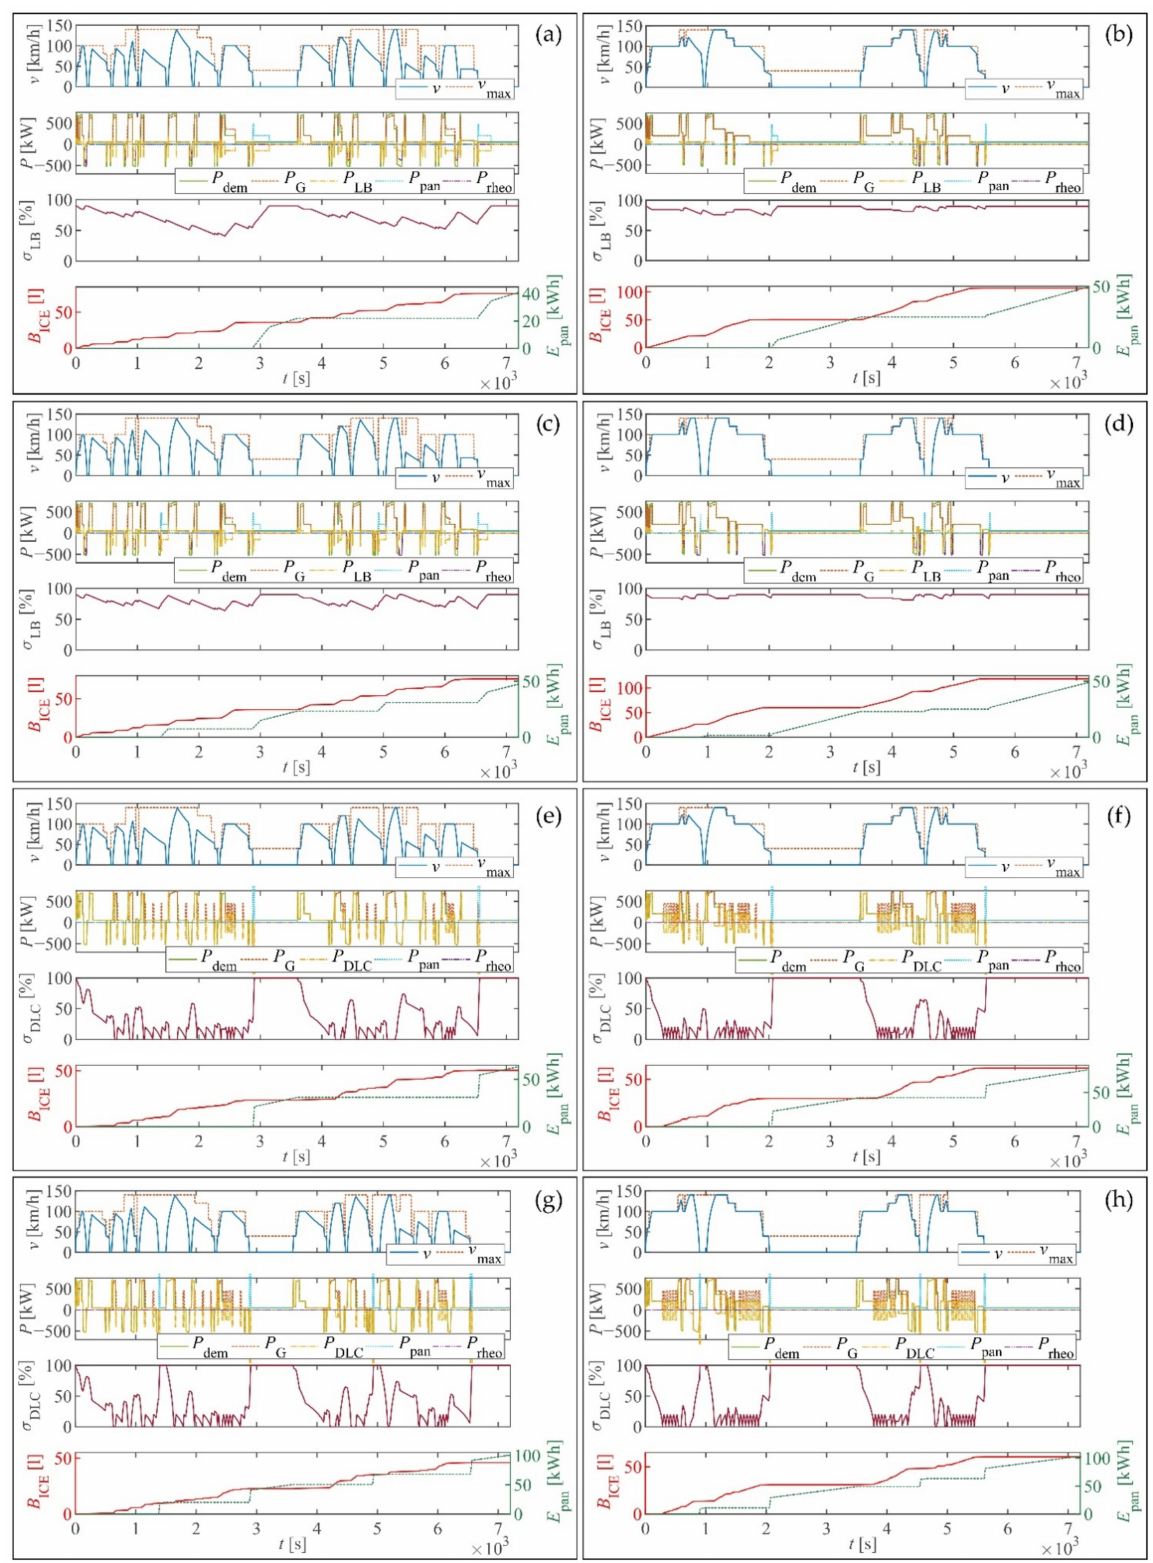
Figure A3. Simulation results for a PHDEMU vehicle on stopping and express service, respectively: ( a , b ) LB ESS with charging at TSs; ( c , d ) LB ESS with charging at TSs and IS; ( e , f ) DLC ESS with charging at TSs; and ( g , h ) DLC ESS with charging at TSs and